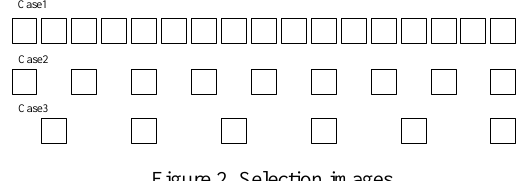
Figure 2. Selection